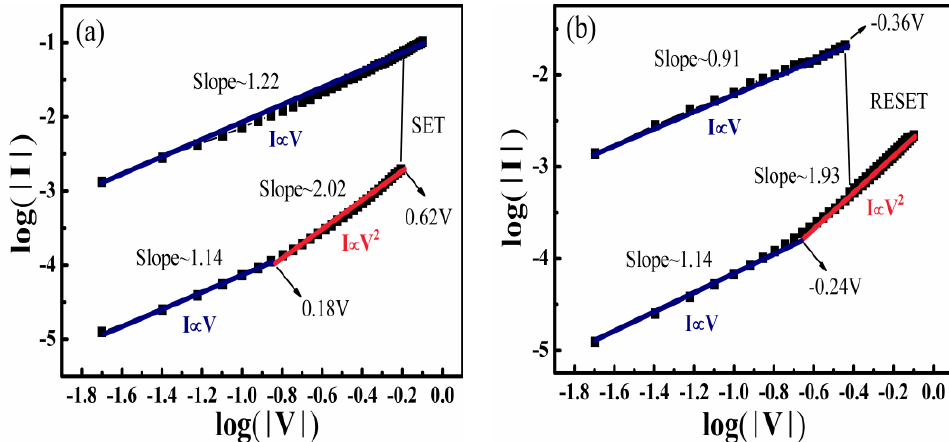
Figure 7. ( a ) Log(I) − log(V) plots of the device under positive voltage and ( b ) under negative voltage. However, in the high-voltage region in the HRS (0.18 ≤ V ≤ 0.62 V for the positive voltage region, and − 0.24 ≤ V ≤ − 0.36 V for the negative voltage region), the slope is approximately equal to two (the slope for the positive voltage region is equal to 2.02, and the slope for the negative voltage region is equal to 1.93), which was subjected to the space-charge-limited conduction (SCLS; Child’s law). It was indicated that the threshold